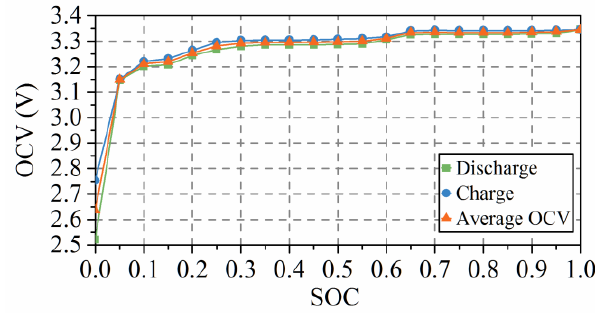
Figure 7. OCV measurement.